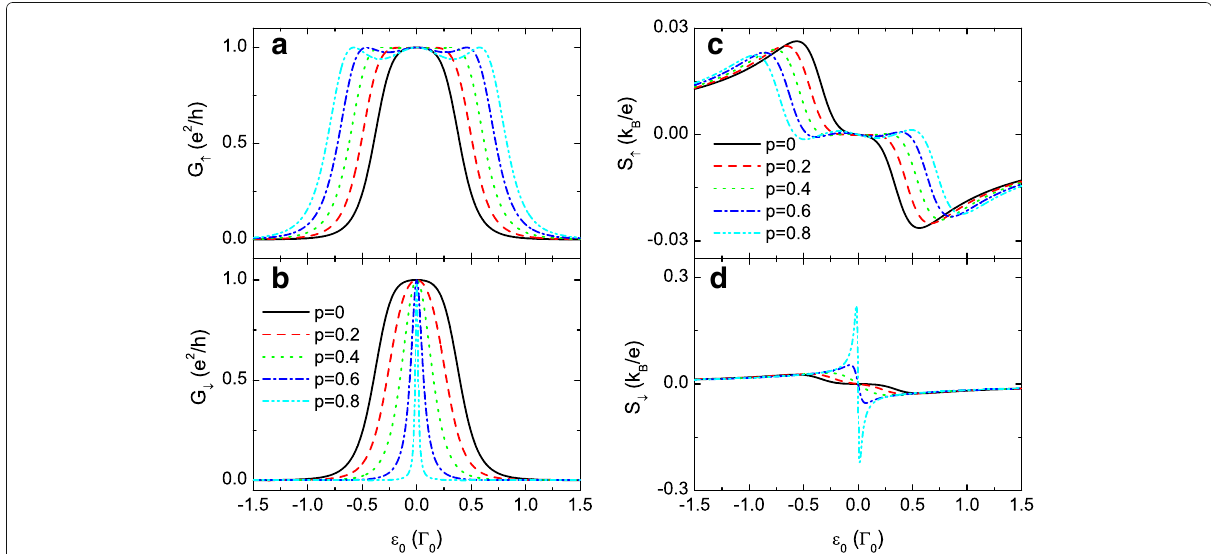
Fig. 2 Conductance and thermopower for t 0 = 0. Spin-polarized conductance G σ in a and b , and thermopower S σ in c and d as functions of the dot level ε 0 for fixed t 0 = 0 and different values of the spin-polarization of the interdot couplings. The other parameters are level detuning (cid:5) = 0, temperature T = 0.001, and t c =